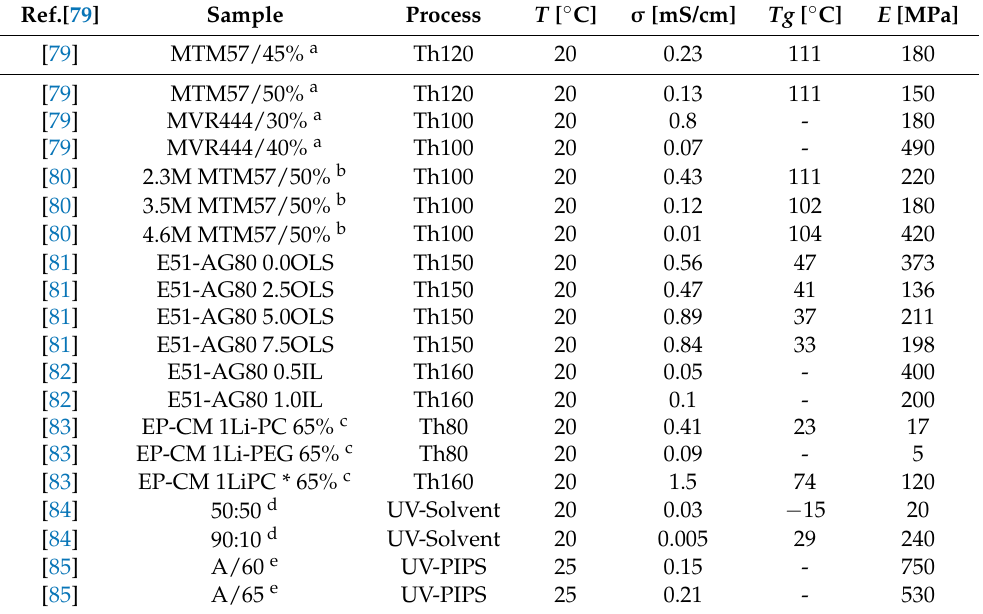
Table 3. Structural polymer electrolytes